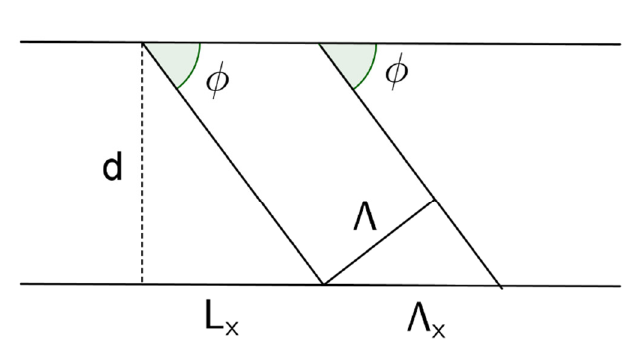
Figure 5. Geometry of the interference